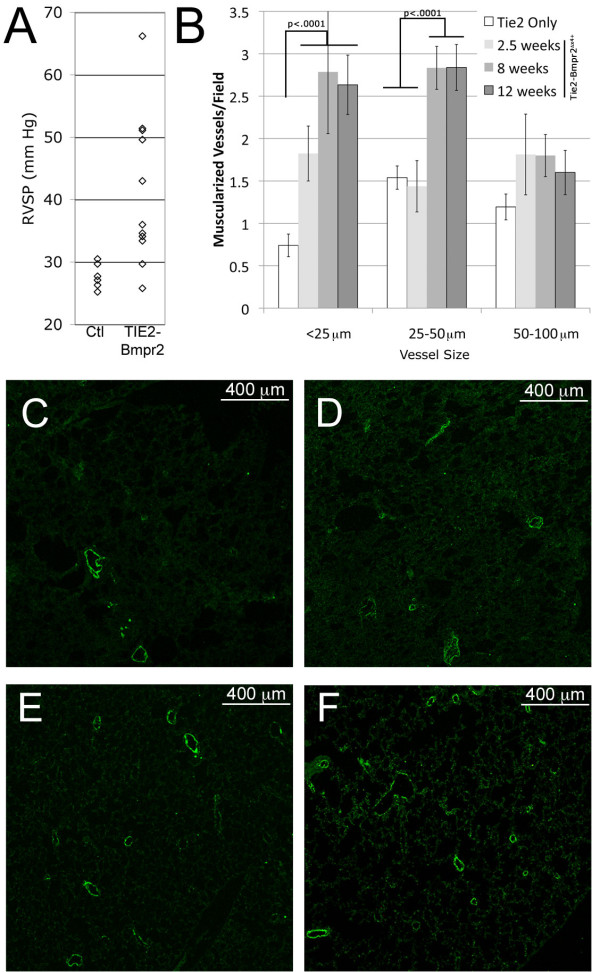
RVSP and muscularization are increased in Tie2- Bmpr2delx4+ mice. (A) Scatter plot showing RV systolic pressures from 11 Tie2- Bmpr2delx4+ mice and 6 control mice after 12 weeks' doxycycline. (B) Graph of muscularization of vessels visualized by actin staining showing a statistically significant increase in vessels under 25 μm compared to control at all time points, and an increase in muscularized vessels 25-50 μm compared to controls at the 8 and 12 week time points (p < .0001 by ANOVA with post-hoc t-test). There is never a statistically significant increase in muscularization in vessels over 50 μm. (C-F) Representative actin staining in control (C), 2.5 week (D), 8 week (E), and 12 week (F) time points, showing a progressive increase in small muscularized vessels.